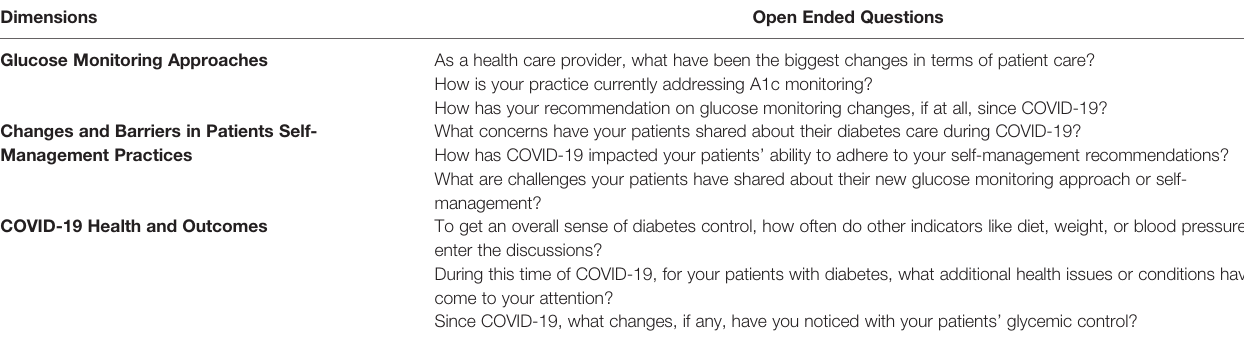
TABLE 2 | Key interview questions.